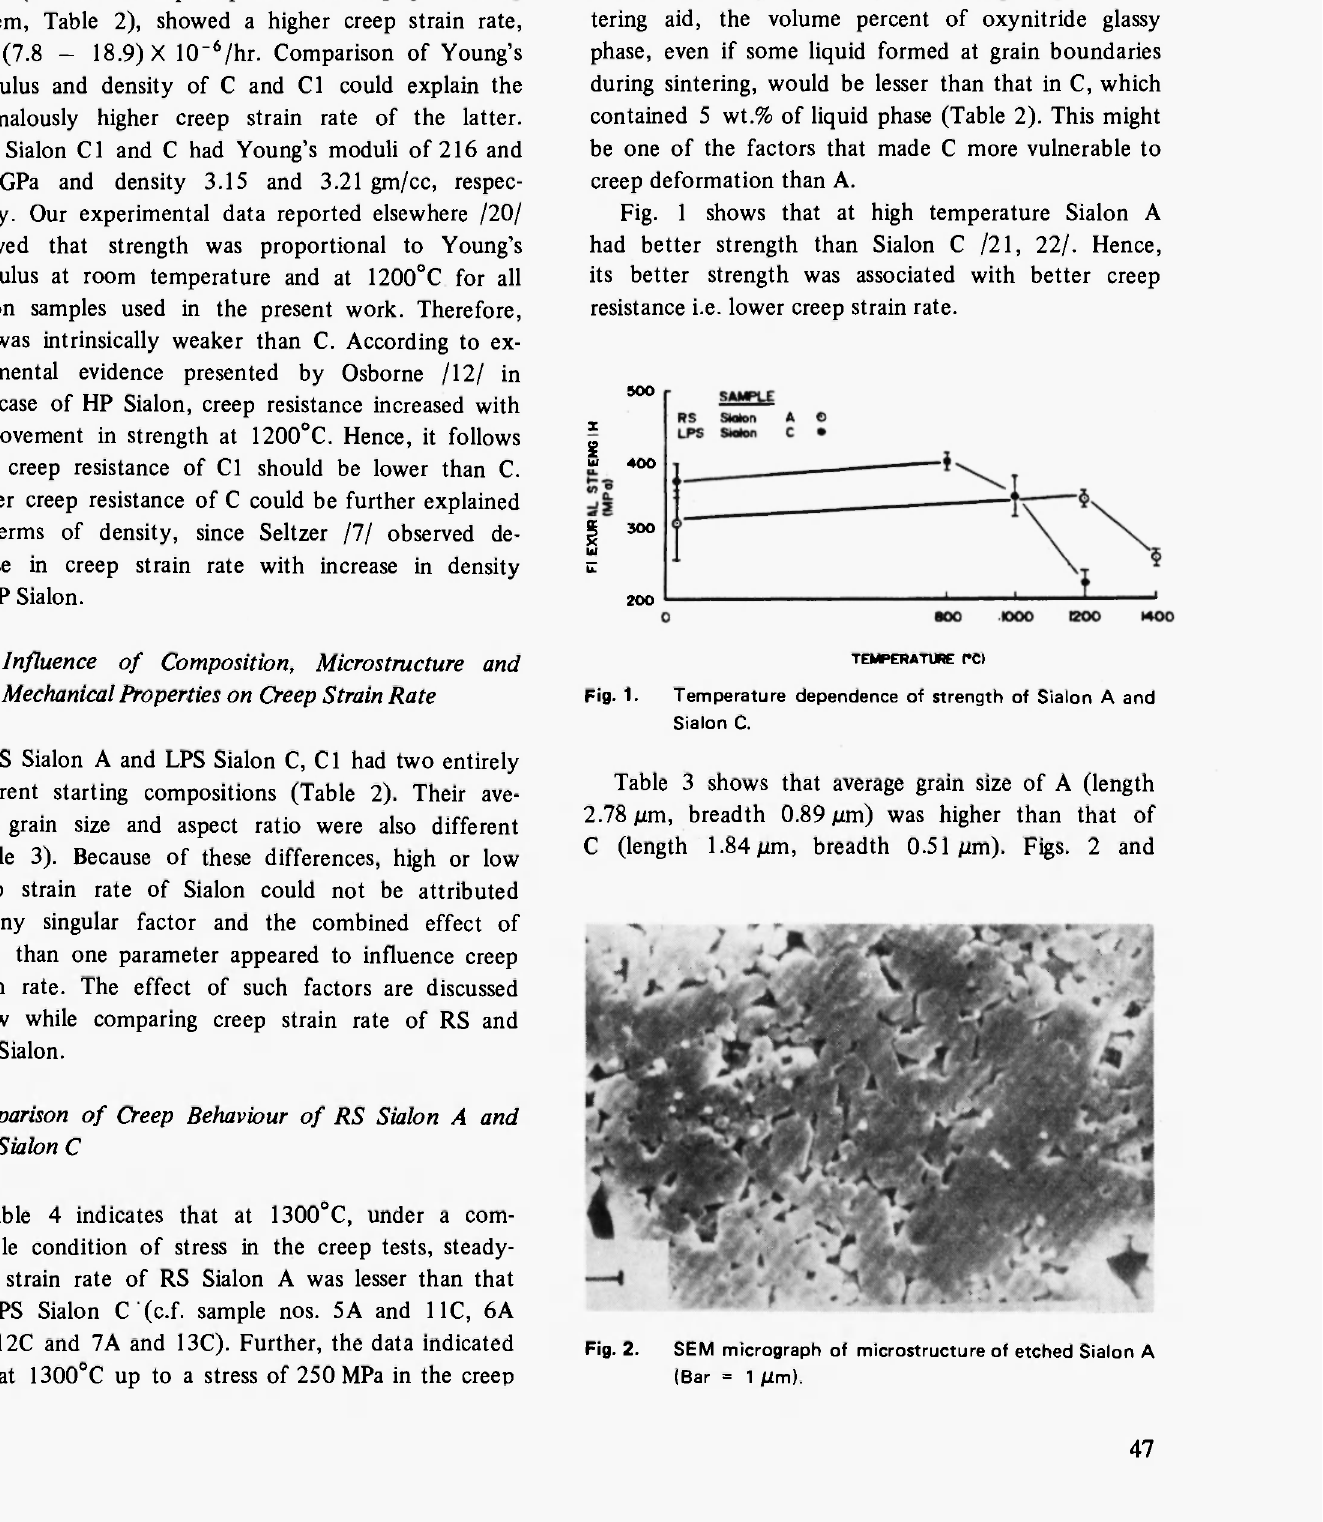
Fig. 2. SEM micrograph of microstructure of etched Sialon A (Bar = 1